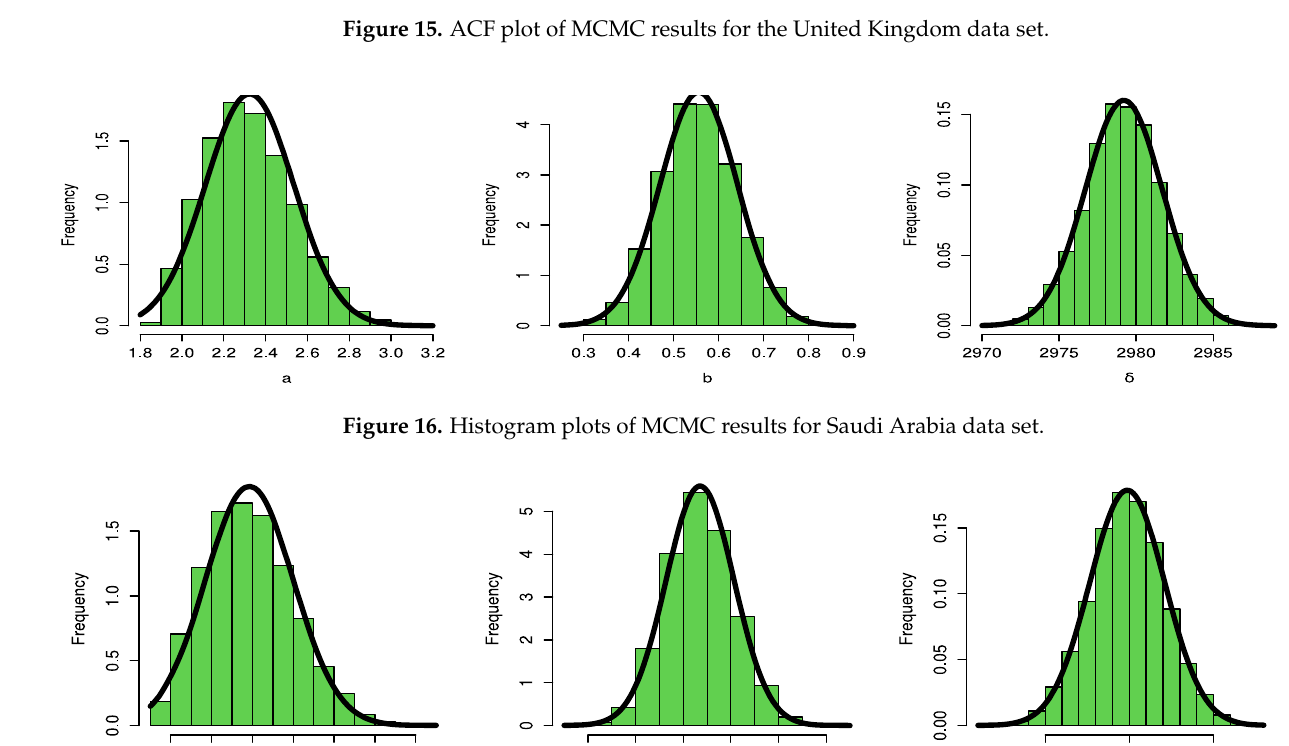
Figure 18. Convergence lines of MCMC results for Saudi Arabia data set.